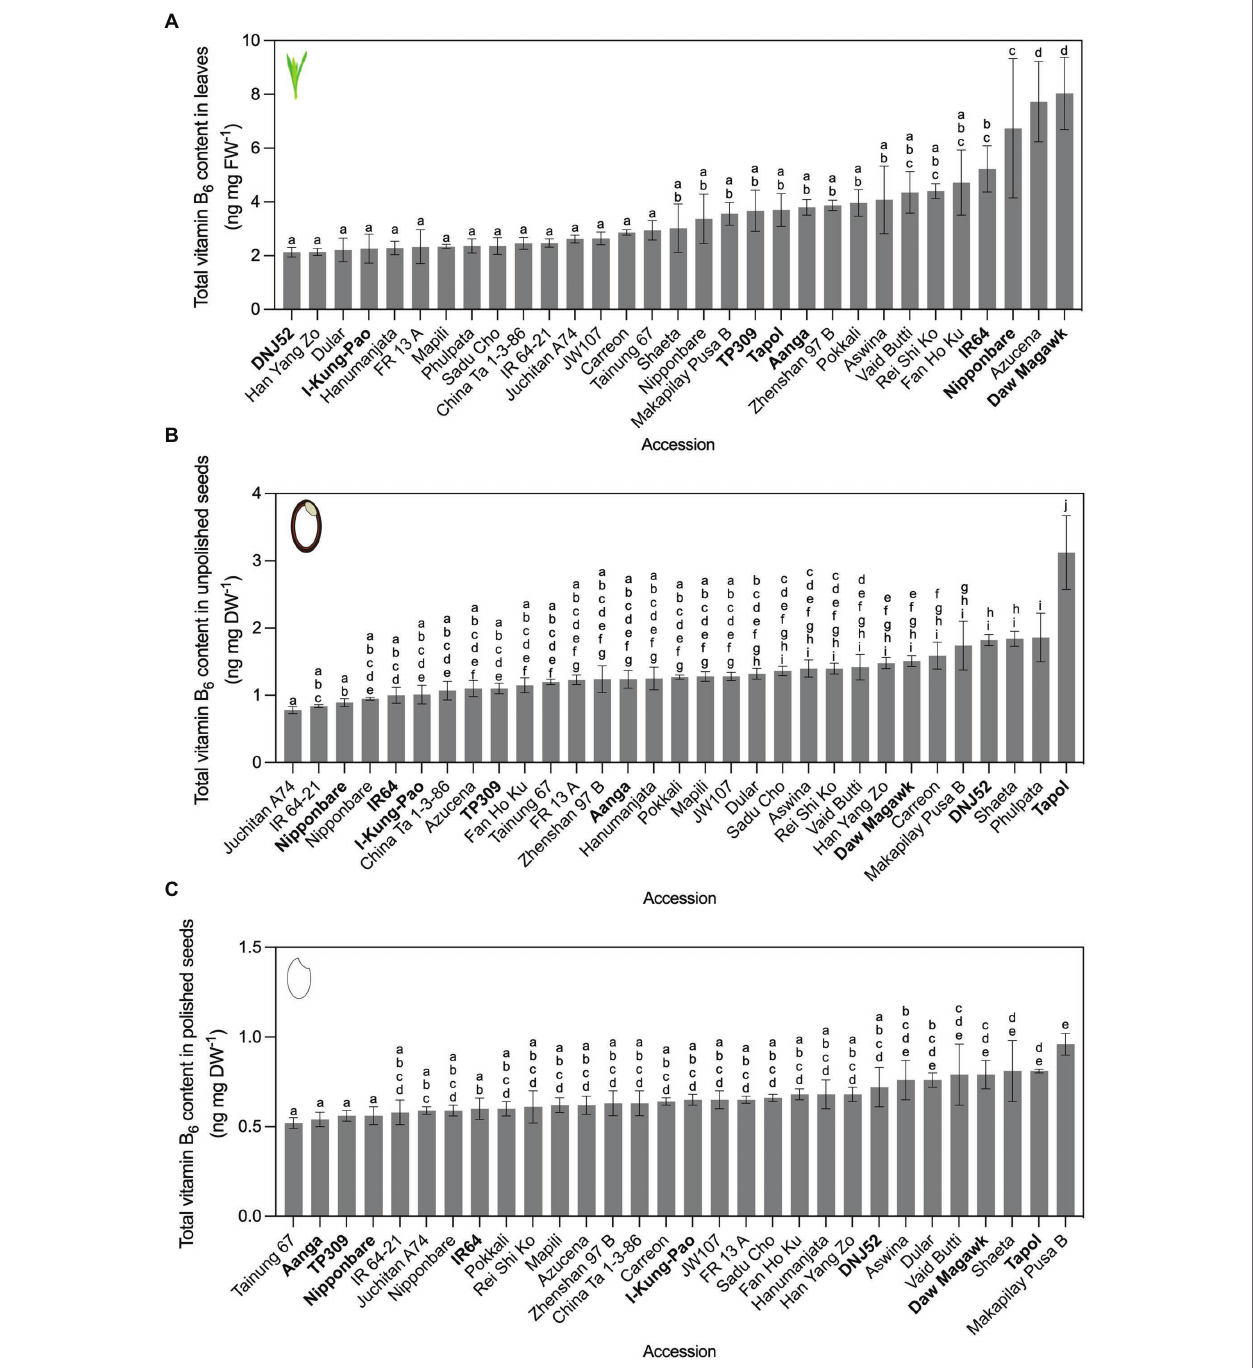
FIGURE 3 | Vitamin B 6 contents quantified by yeast assay. Leaves (A) , unpolished seeds (B) , and polished seeds (C) in contrasting rice accessions grown under greenhouse conditions and quantified by yeast assay. Twenty-one accessions cultivated in experiment 1 were re-sown, alongside 10 additional accessions from the Oryza SNP Project (experiment 2). The accessions with vitamin B 6 content below the 25th percentile of the distribution were considered as low vitamin B 6 accessions and those with vitamin content above the 75th percentile were considered as high vitamin B 6 accessions. Low, intermediate, and high vitamin B 6 accessions selected for HPLC analysis are bolded. Mean ± SD of 3 biological replicates, except Nipponbare ( n = 6), IR64 ( n = 6), and TP309 ( n = 6) for the three tissues; IR 64–21 ( n = 2) for leaves; Nipponbare ( n = 2) and IR 64–21 ( n = 2) for unpolished seeds; and Nipponbare ( n = 2), IR 64–21 ( n = 2) and Phulpata ( n = 0) in polished seeds. The effect of accession on total vitamin B 6 contents in panels (A–C) was determined by one-way ANOVA ( α = 0.05) with multiple comparisons and Tukey’s post-hoc test. Statistically significant differences between accessions are denoted by different